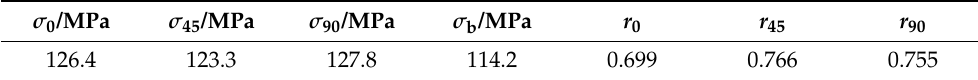
instability criterion.